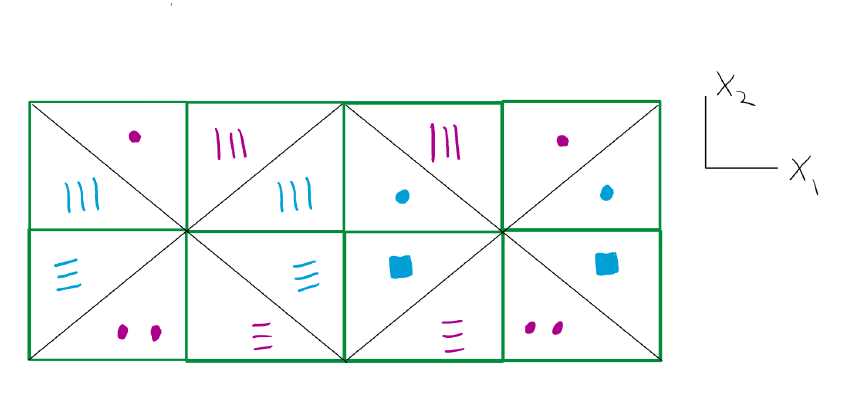
Figure 12: Here we depict the gluing procedure for the minimal hyperbolic 3- manifold in [ 25 ] , gluing each color to its image under reflection about any facet of its color. As above, color B is pink and C is